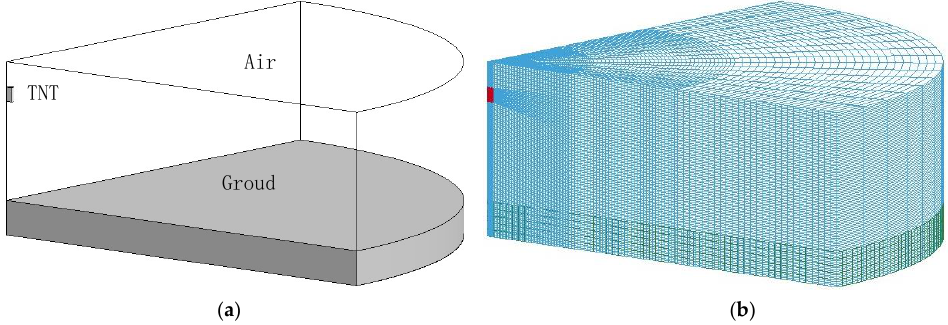
Figure 2. Physical model and finite element model of near-ground explosion . ( a ) Physical model; ( b ) Finite element model.